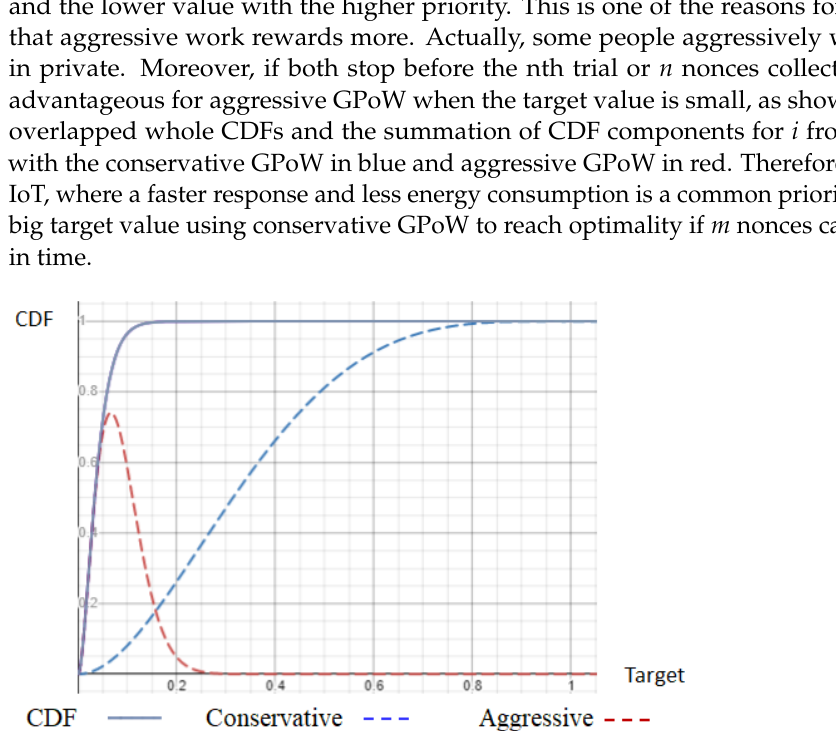
Figure 5. CDF is the CDF of conservative GPoW, ∑ n ∑ n ( n ) u i ( 1 − u ) n − i , overlapped, n = 50, m = 2. Conservative = ∑ m + 3 i = m i